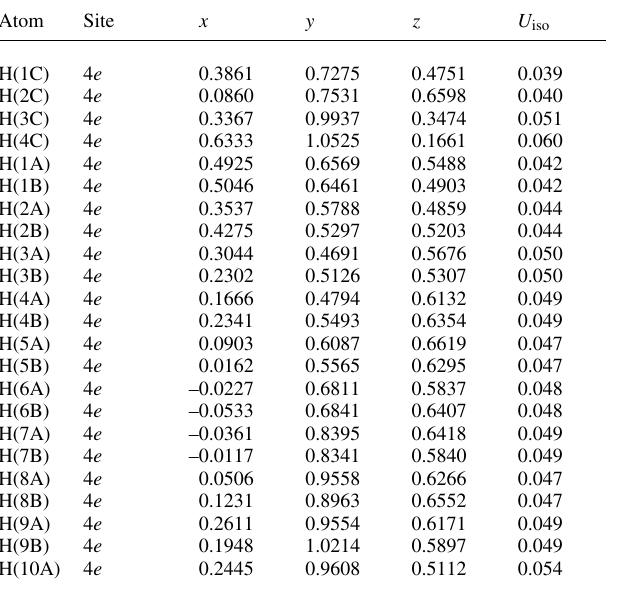
Table 2. Atomic coordinates and displacement parameters (in Å 2 )